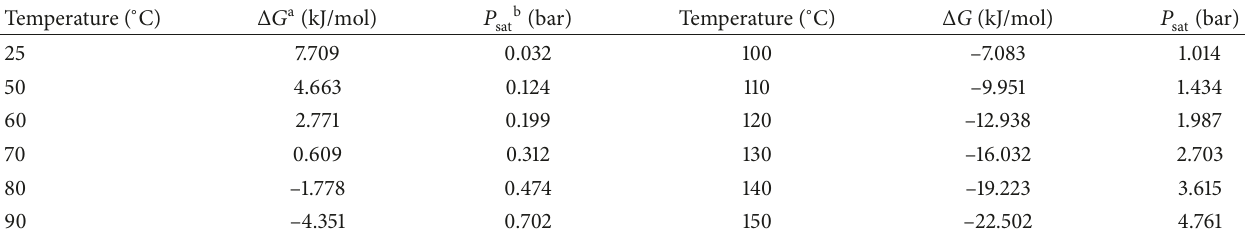
Table 3: The Gibbs free energies of the reaction 3CaMg(CO 3 ) 2 + 4SiO 2 ( aq ) + H 2 O = Mg 3 (Si 4 O 10 )(OH) 2 + 3CaCO 3 + 3CO 2 at the temperatures of interest and their corresponding saturation